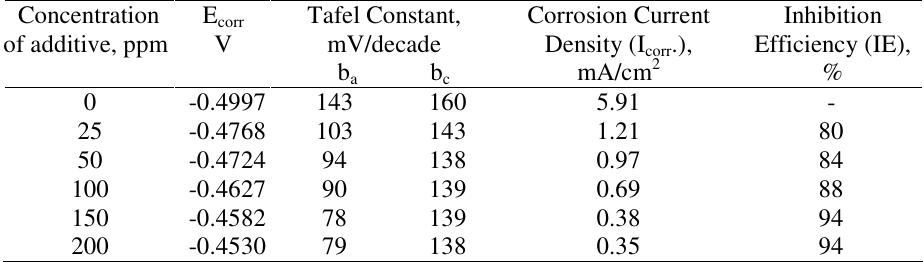
Table 2. Effect of F. exasperata extract on corrosion of MS in 1N H by Tafel polarisation method